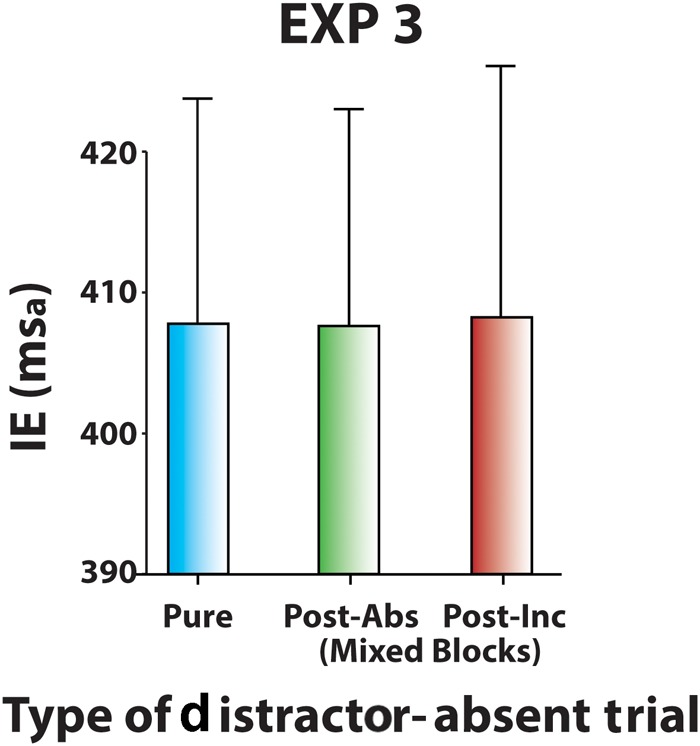
Experiment 3: Sequential effects on mean IEs of distractor-absent trials in Pure block, in Mixed blocks following distractor-absent trials, and in Mixed blocks following incongruent distractor trials. Data of Mixed blocks were obtained by collapsing 60% Cong block and 60% Inc block data. Error bars represent the standard error of the means across participants.